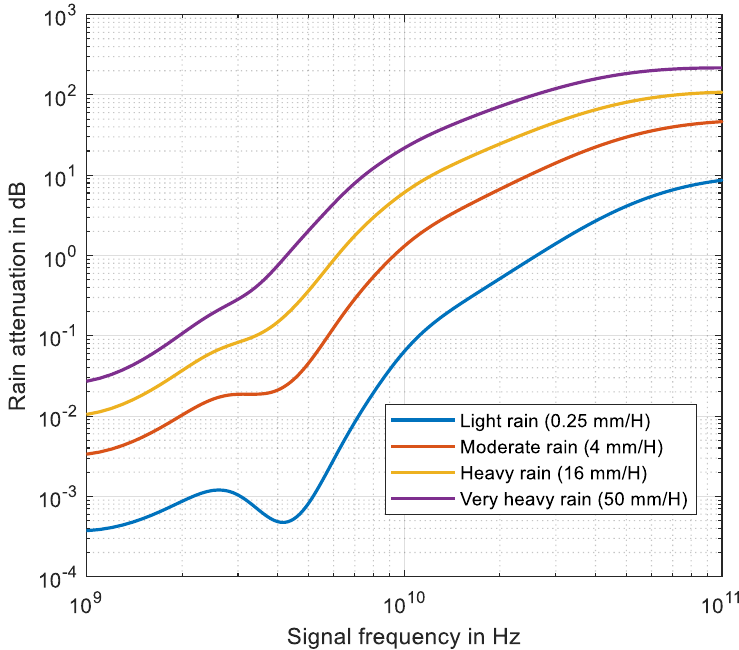
Figure 16. Airport maximum rain attenuation for aircraft – SB communication.